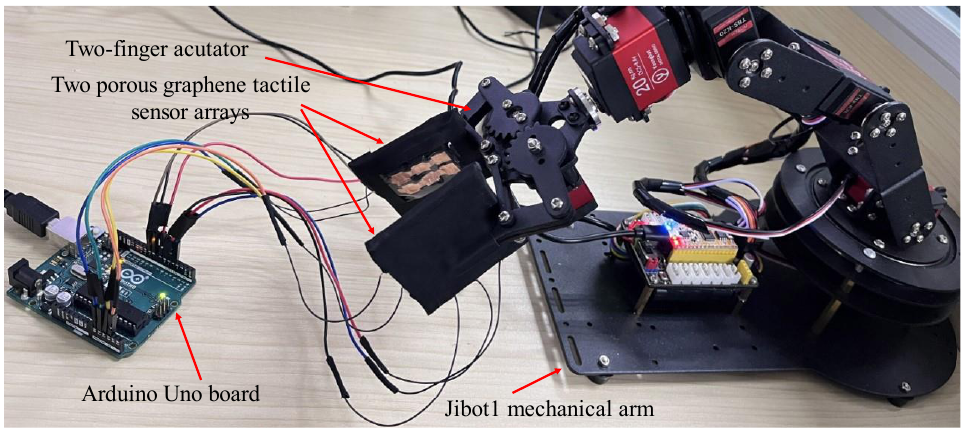
Figure 5 . Data acquisition platform. Figure 5. Data acquisition